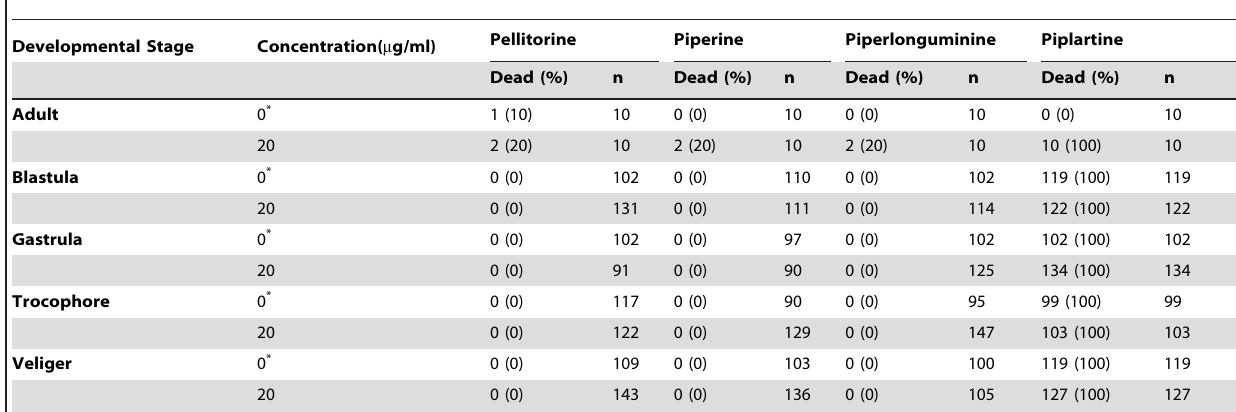
Table 2. Mortality of B. glabrata adults and embryos exposed to amides (20 m g/ml).